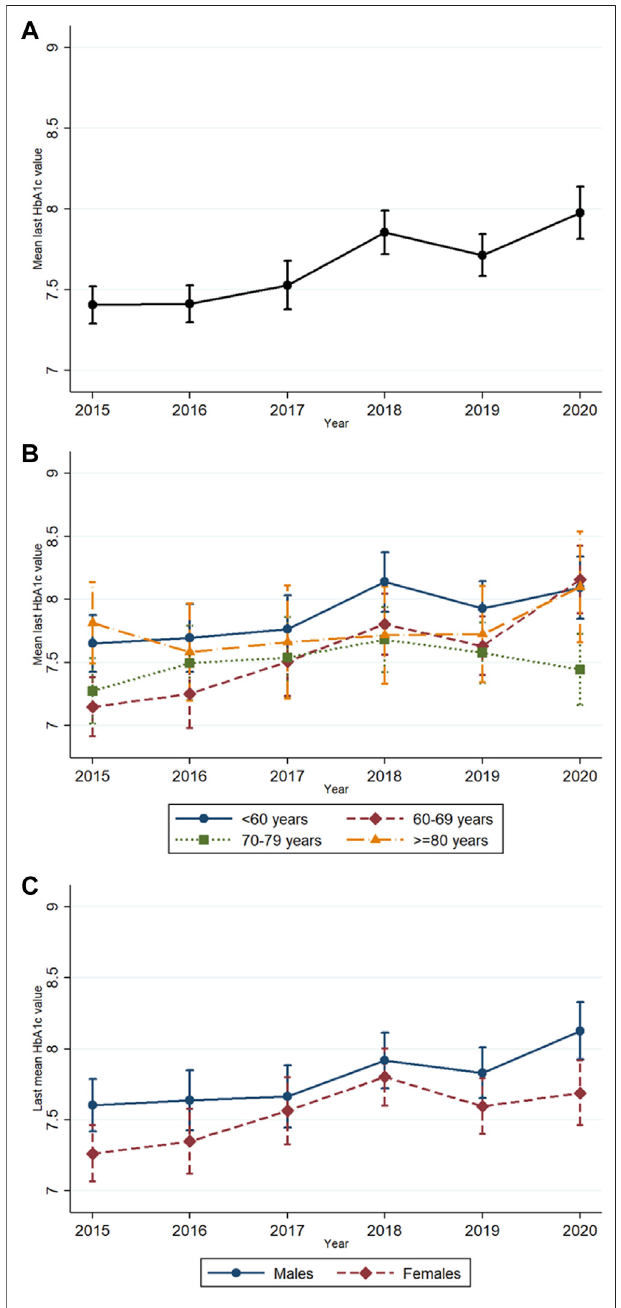
FIGURE 1 | Mean last glycosylated hemoglobin A1c (HbA1c) levels adjusted for all potential confounders with 95% con fi dence intervals before/at initiation of glucose-lowering medication from 2015 to 2020 in (A) the whole population, (B) different age groups, and (C) by